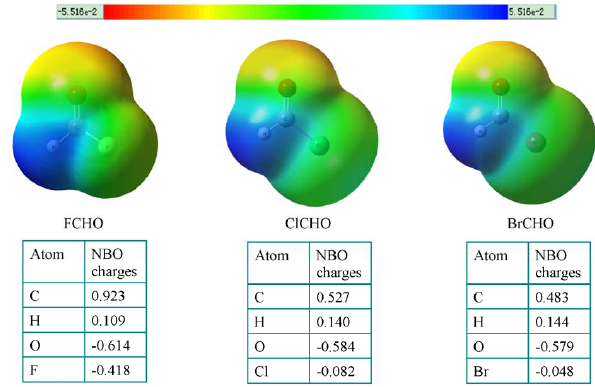
Fig. 1. Calculated molecular electrostatic potential and NBO charges (in e) for the Fig. 1 . Calculated molecular electrostatic potential and NBO charges (in e) for the reactants. 3 4